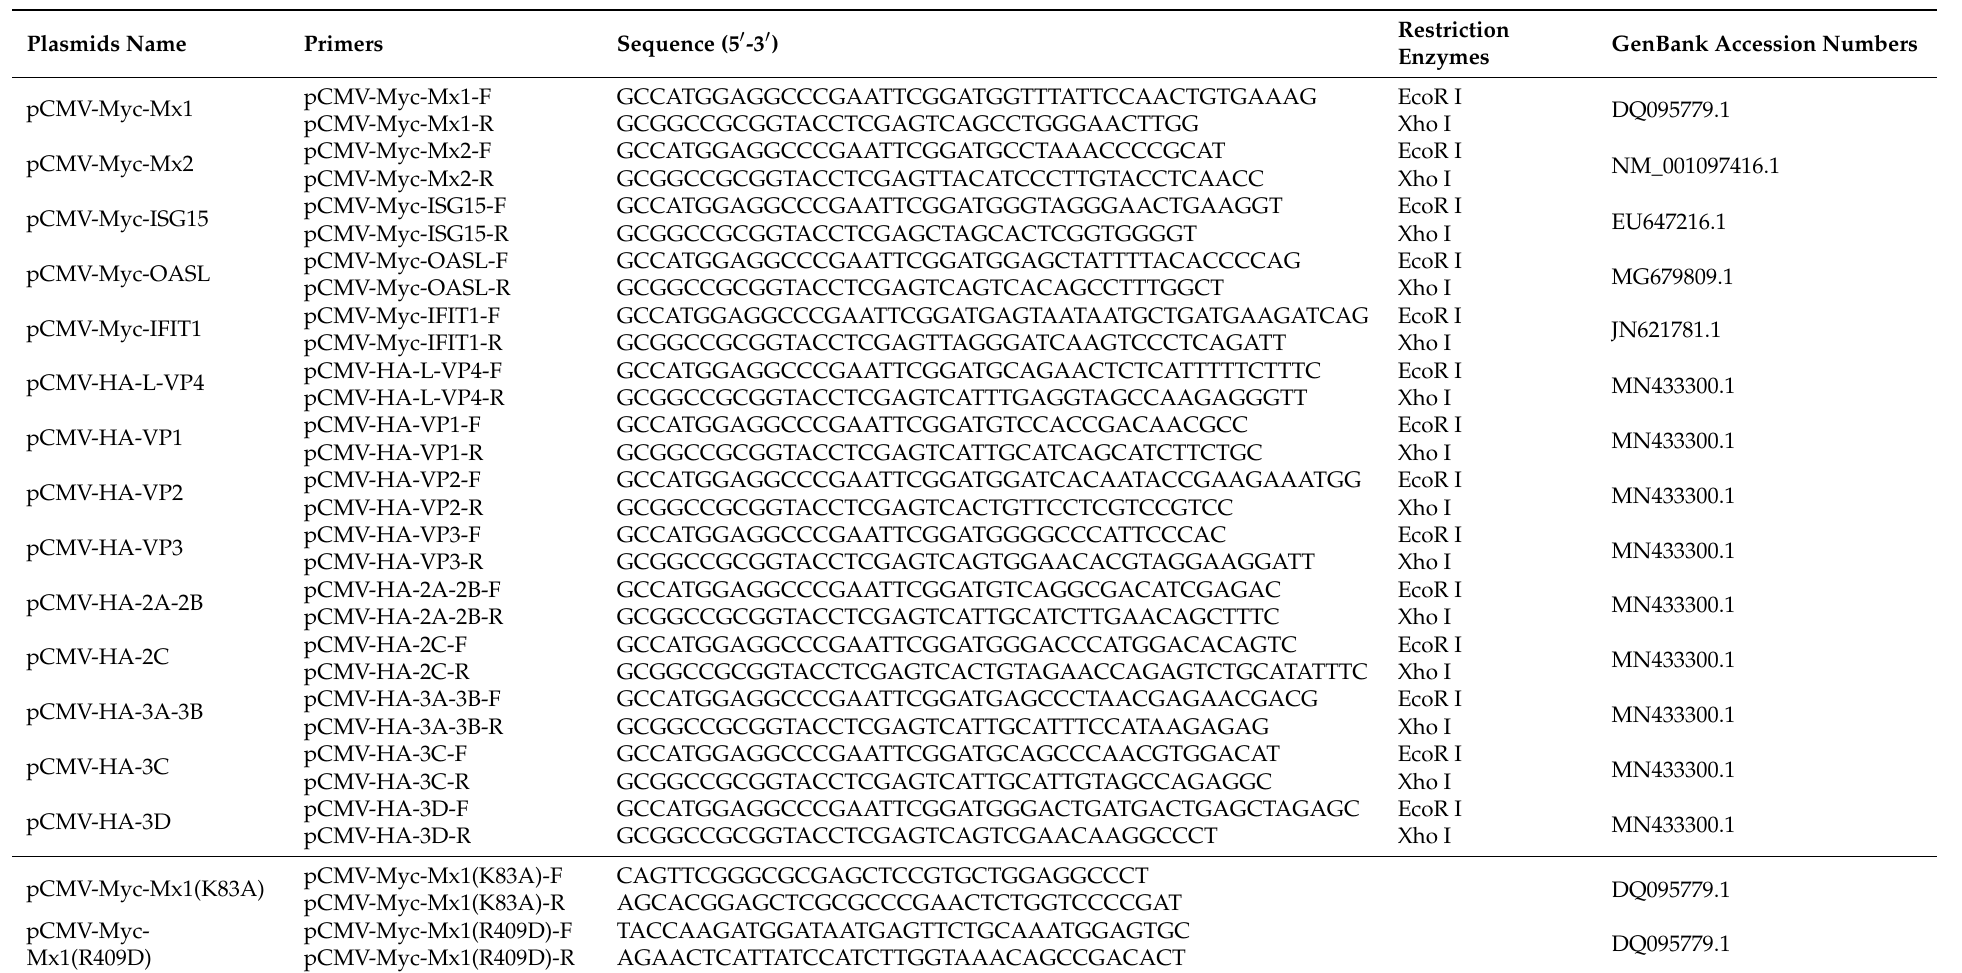
Table 1. The primers used in this